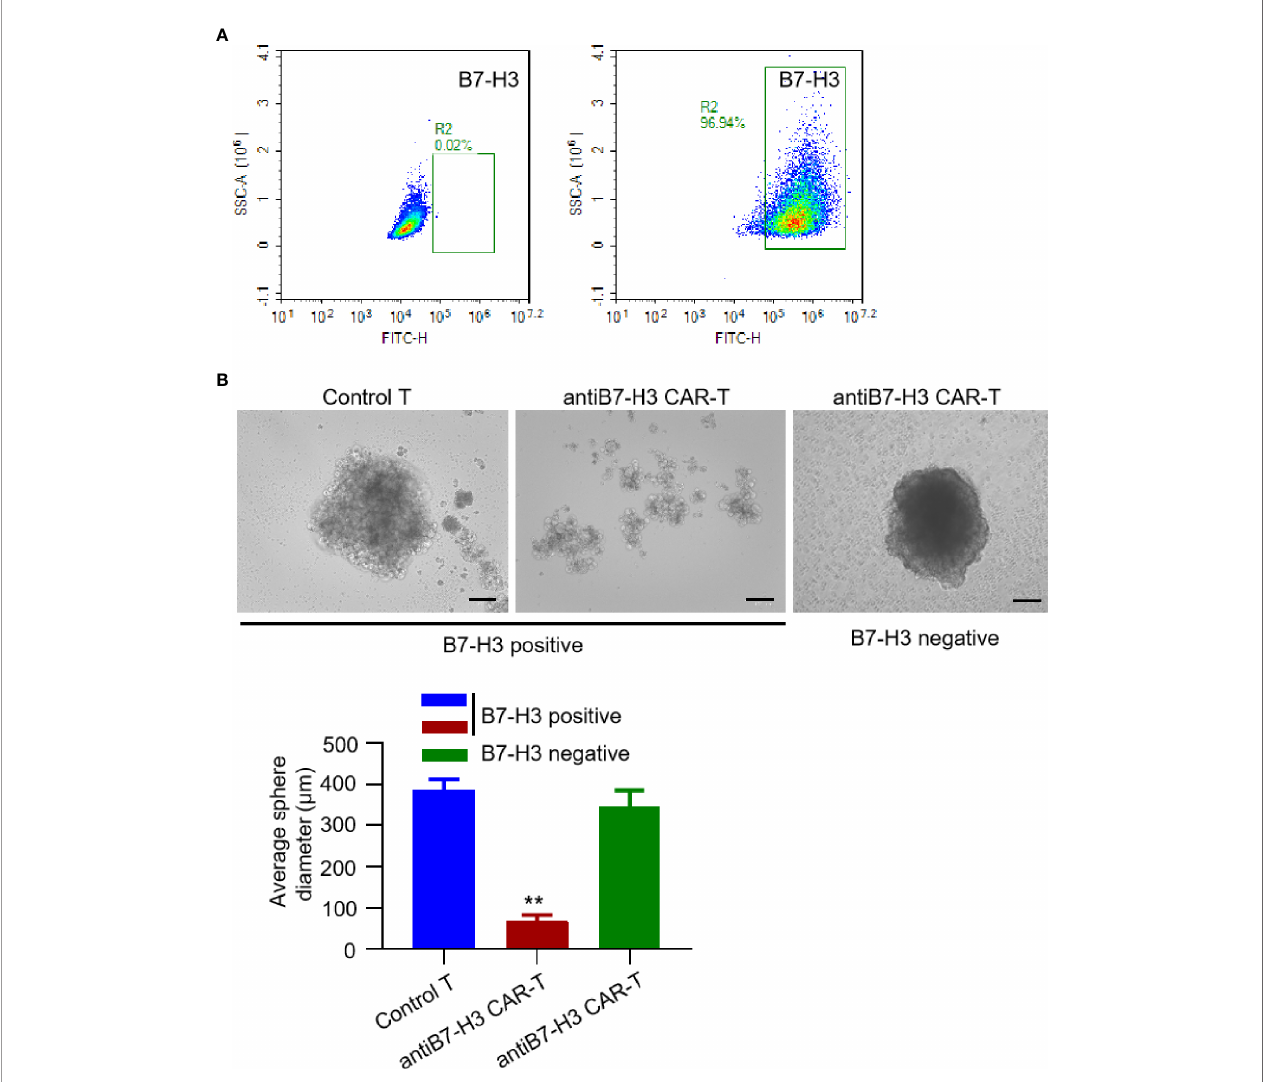
FIGURE 3 | B7-H3-retargetedCAR-T cells suppressed chordoma tumor sphere formation. (A) Representative images of FACS examination of B7-H3 expression on primary chordoma cells isolated from two different clinical samples. (B) Representative images of B7-H3-retargeted CAR-T cells inhibited the tumor sphere formation of chordoma. Scale bars: 100 m m. **p <